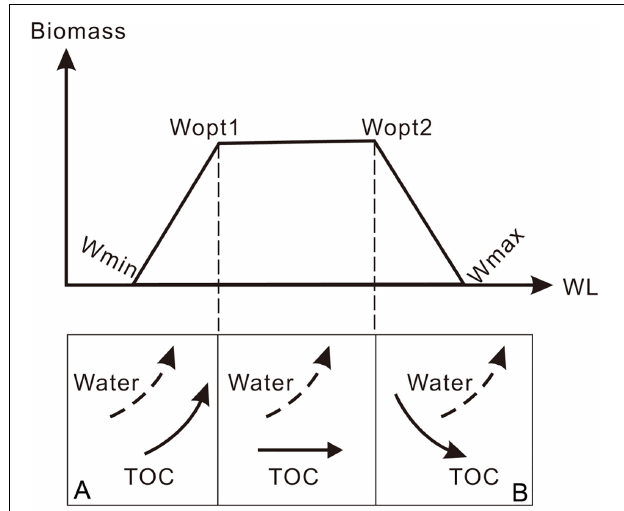
FIGURE 1 | Conceptual model showing the relationship between the water content of soil (WL) and soil carbon accumulation (CA). The upper plot is for the WL (horizontal axis) and plant production (ordinates) and the lower for the WL and carbon accumulation. A and B show the typical relationship between the WL and CA in two contrasting hydrological